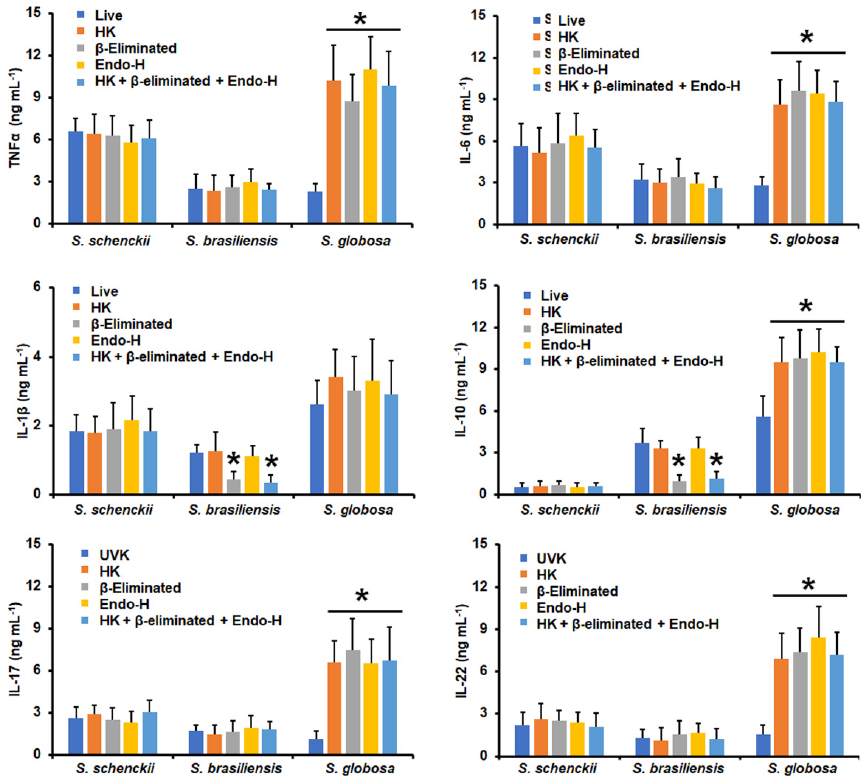
Figure 5. Cytokine production by human peripheral blood mononuclear cells stimulated with germlings from Sporothrix schenckii , Sporothrix brasiliensis , or Sporothrix globosa . For tumor necrosis factor-alpha (TNF α ), interleukin 1 β (IL-1 β ), interleukin 6 (IL-6), and interleukin 10 (IL-10), human peripheral blood mononuclear cells were co-incubated for 24 h with conidia previously subjected to the indicated treatments (see Materials and Methods for details). Alternatively, for interleukin 17 (IL-17) and interleukin 22 (IL-22) stimulation, the human cells were co-incubated with the UV-killed fungal cells or subjected to the indicated treatments. In all cases, the interactions were centrifuged, supernatants collected, and cytokines quanti fi ed by ELISA. UVK—UV-killed cells; HK—heat-killed cells; Endo-H—treatment with endoglycosidase H. Results are the median ± standard deviation from data generated with samples from eight donors, analyzed in duplicate. * p < 0.05 when compared with the cytokine level stimulated by live or UV-killed cells.